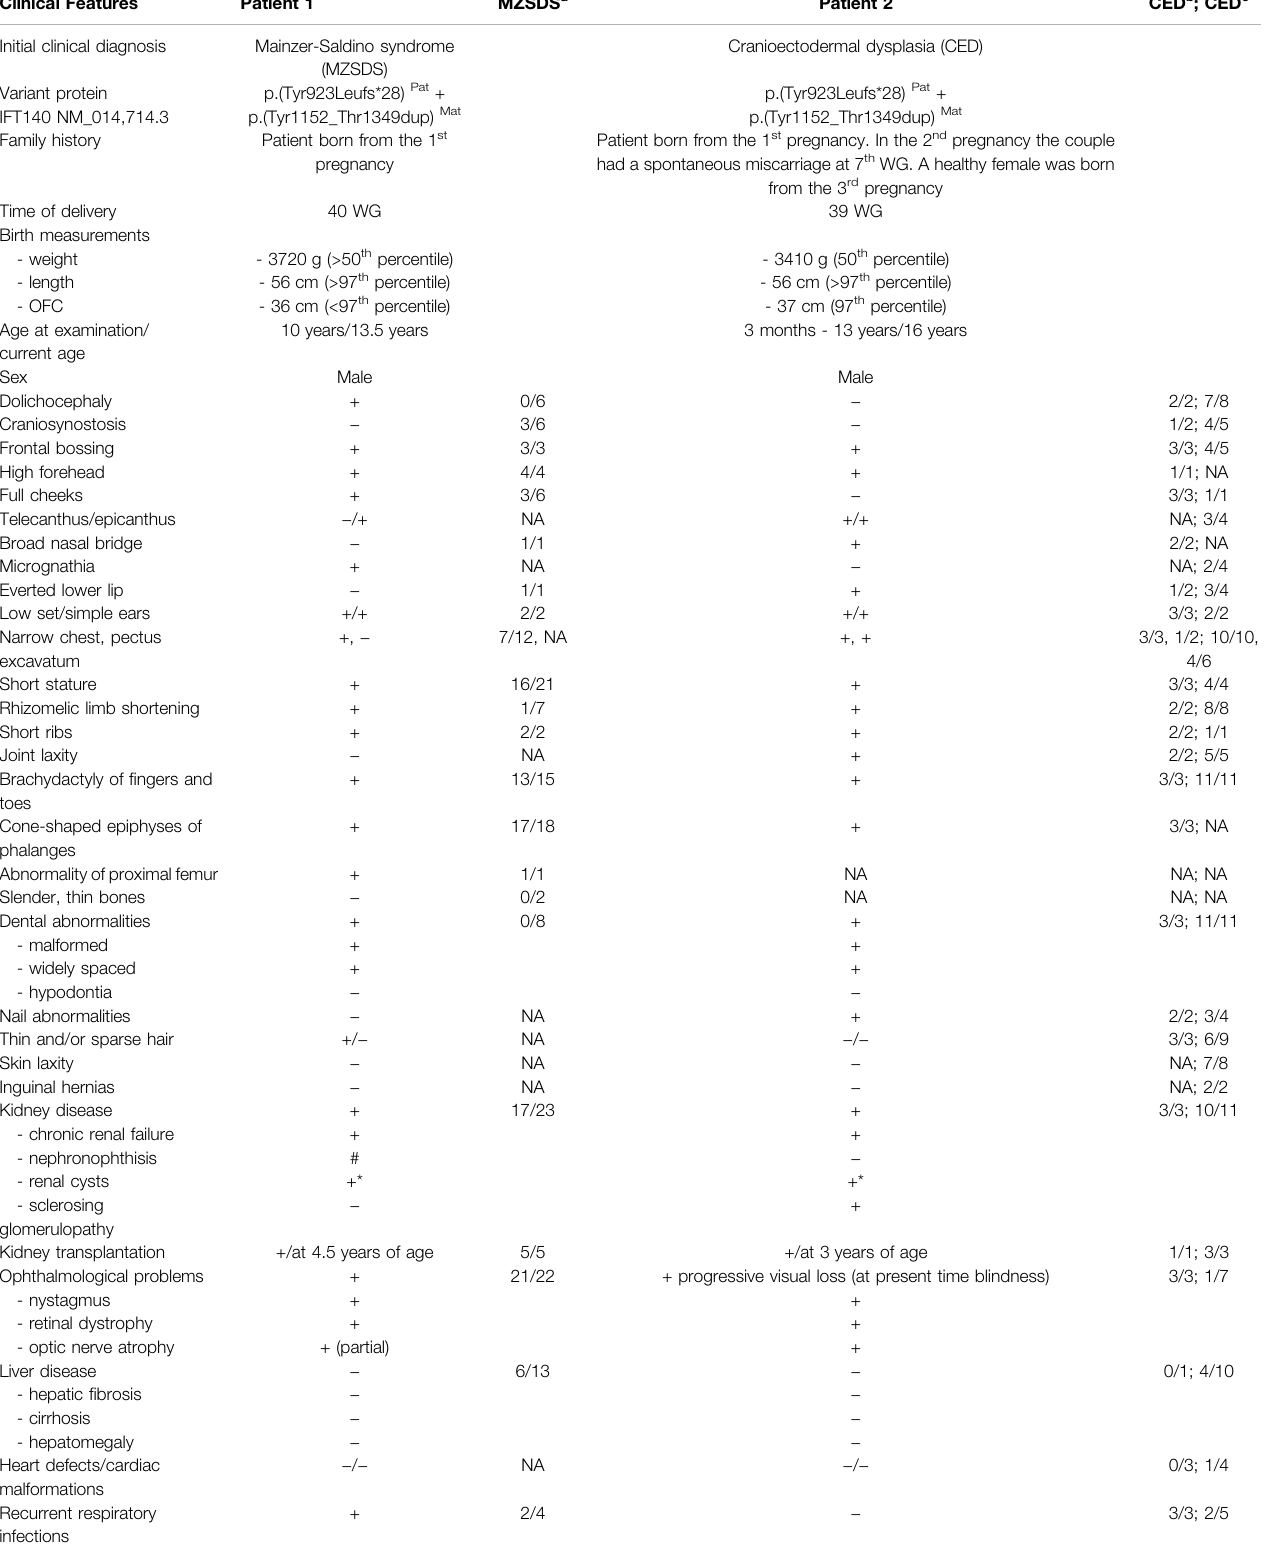
TABLE 1 | Clinical features of patients with compound heterozygous variants in IFT140 described in this study and in literature. Clinical